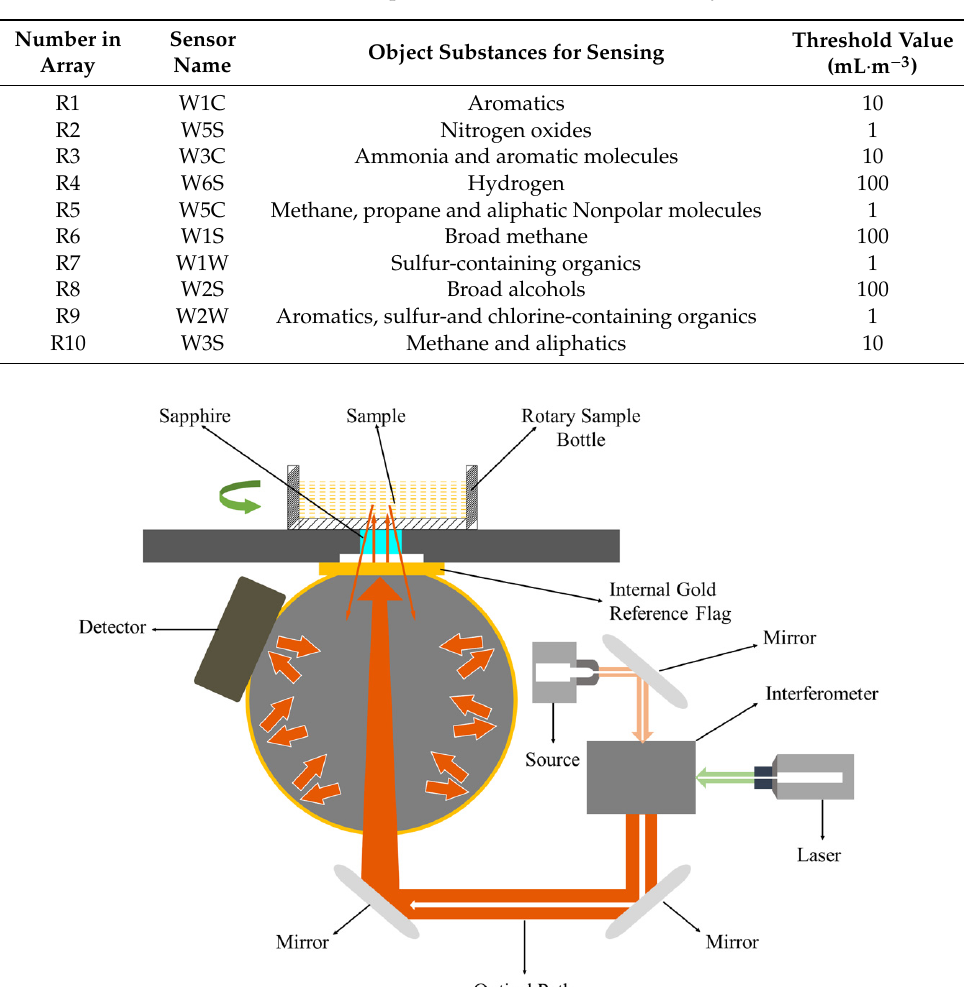
Table 3. The response features of the sensor array.